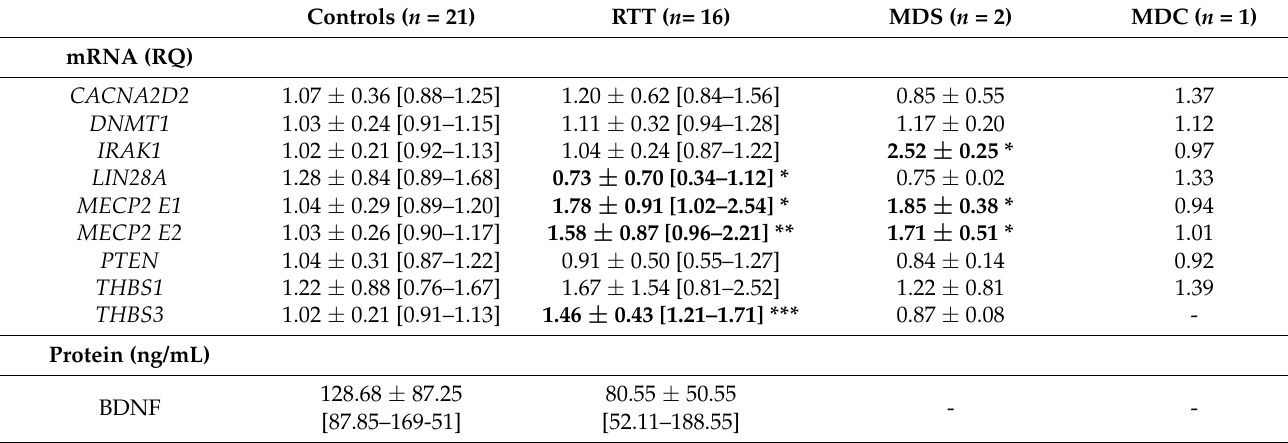
Results shown as mean ± standard deviation, [inferior-superior] 95% confidence interval. Statistically significant differences highlighted in bold. * p < 0.05, ** p < 0.01, *** p < 0.001 indicate significant differences with respect to the control group (Mann–Whitney U Test). RQ: relative quantification; MDC: MECP2 duplication